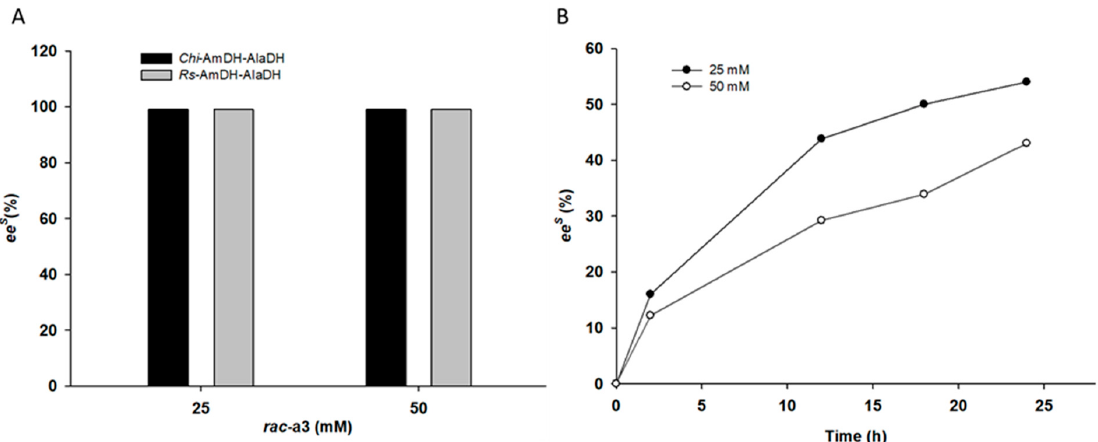
Figure 5. ( A ) Kinetic resolution of increased concentration of rac- a3 and ( B ) Time profile of the kinetic resolution of rac- a7 (25 and 50 mM) using AmDH-AlaDH purified enzyme system. Reaction conditions: 25/50 mM rac -a7 (or rac -a3 ), 1 mM NAD + , 1 mg/mL AmDH, 1 mg/mL AlaDH, 50/100 mM Pyruvate, 100 mM Glycine buffer (pH 9.5/10.0), 37 °C, 200 rpm for 24 h.